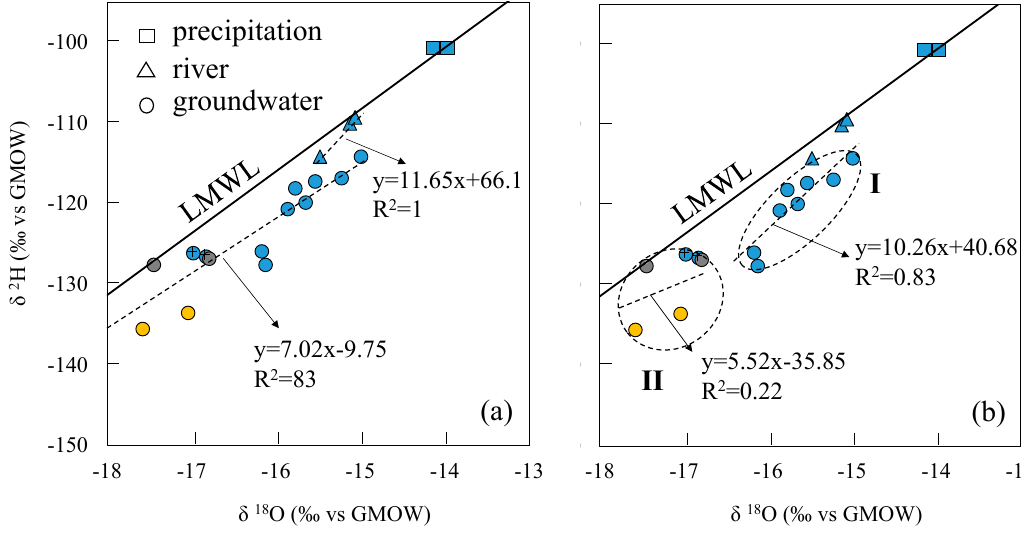
Figure 5. ( a ) Relationship between 2 H and 18 O for the river water and the groundwater samples; ( b ) relationship of 2 H and 18 O for different groups of the analyzed water samples. LMWL represents the local meteoric water line. Squares are rain samples, triangles are river samples, circles are groundwater samples, and circle with a cross are the water samples at the borehole ZK. Yellow represents the spring at Zhanggu, grey represents the spring at Kemu, and blue represents the rest. Group I represents the shallow groundwater, and group II represents the deep groundwater.